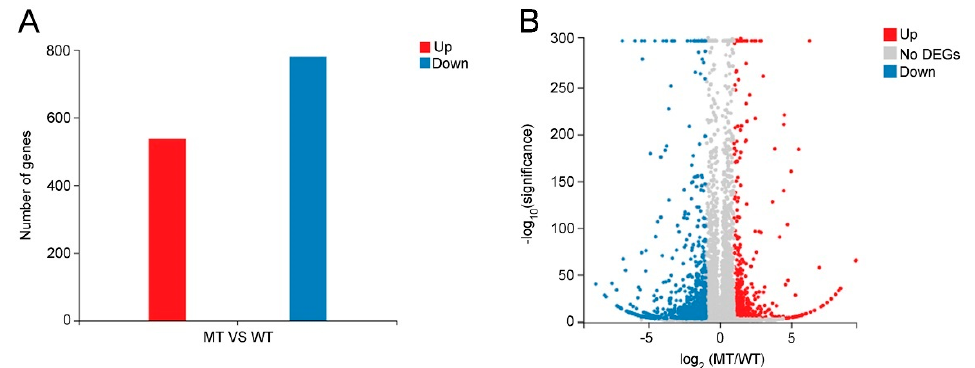
Figure 6. The differentially expressed genes (DEGs) identified in MT vs. WT according to the criteria of |log 2 (MT/WT)| ≥ 1 and Q-value < 0.001. ( A ) The number of upregulated and downregulated DEGs. ( B ) The volcano plot of DEGs. The red and blue colors indicate upregulated and downregu- lated DEGs, respectively. The gray color indicates genes with no significant expression difference between WT and MT.